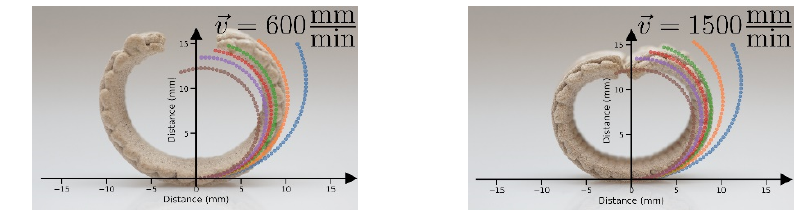
Figure 4. Applying the curvature model on 3D warped objects at different velocities. The dashed lines are the profiles resulting from our numerical model for different values of κ 0 . The resulting values vary from 0.1 mm − 1 to 0.14 mm − 1